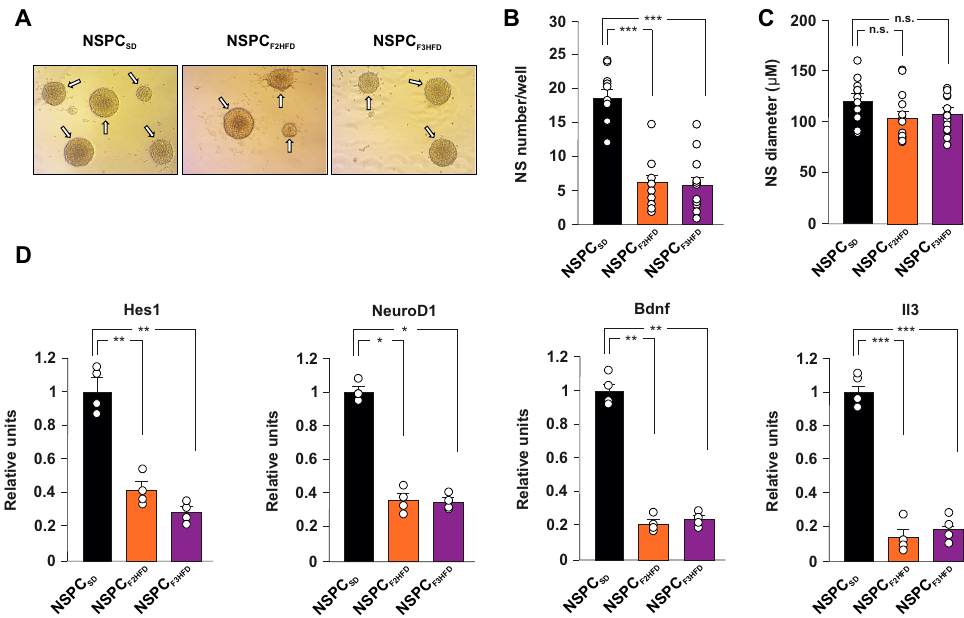
Figure 4. HFD descendants-derived NSPCs showed reduced proliferation and altered gene expression in vitro. ( A ) Bright-field images of SD, F2 HFD and F3 HFD mice derived-NSPCs (NSPC SD , NSPC F2HFD and NSPC F3HFD , respectively). Scale bar = 100 µ m. ( B ) Bar graphs showing the number and ( C )